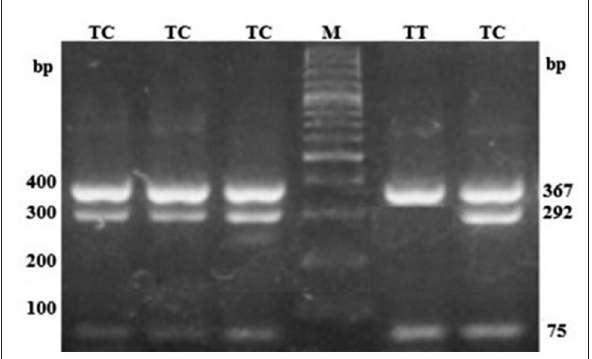
Figure-6: Polymerase chain reaction-restriction fragment length polymorphism profile